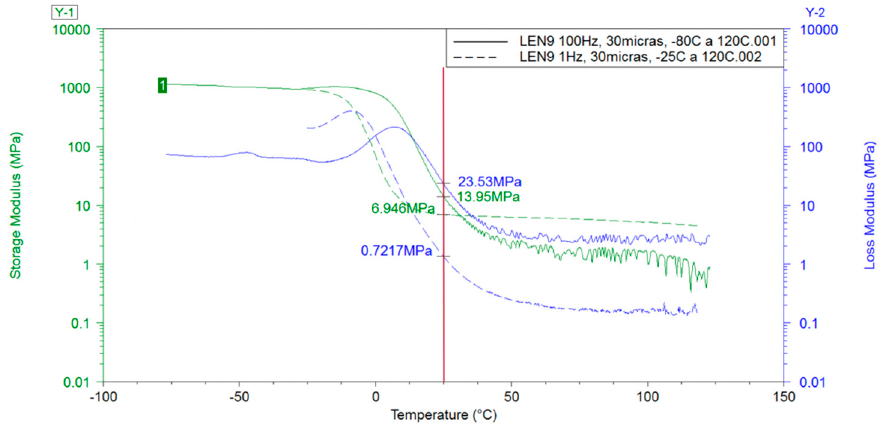
Figure 9. DMTA developed Testing for prototype LEP used in this work, only valid for low frequencies 1Hz up to 100 Hz but considering Temperature variation.